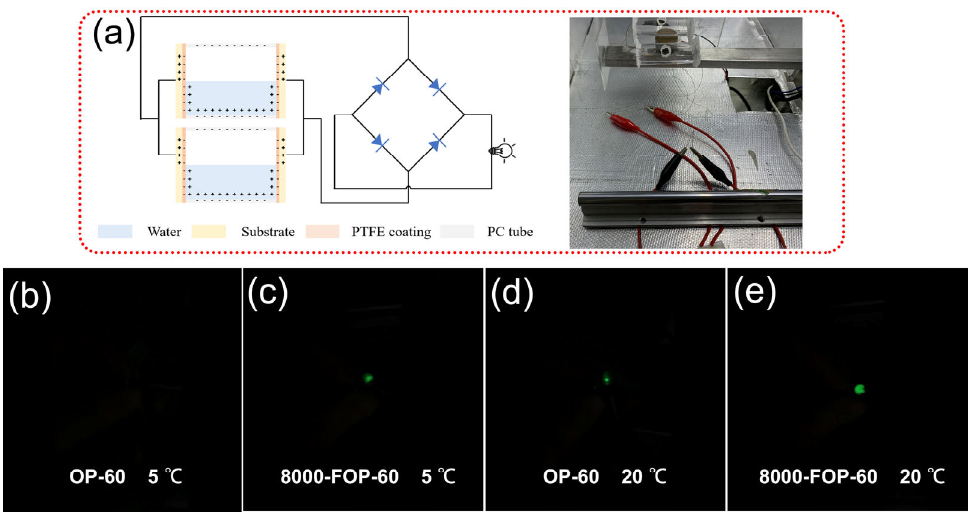
Fig. 7 (a) Schematics and photographs of the integrated circuit to lit the LED (2.2 V, 0.2 μ A). Photographs of the lighting LED demonstration (b, c) at 5 °C of OP-60 TENG and 8000-FOP-60 SLIPSs TENG, and (d, e) at 20 °C of OP-60 TENG and 8000-FOP-60 SLIPSs